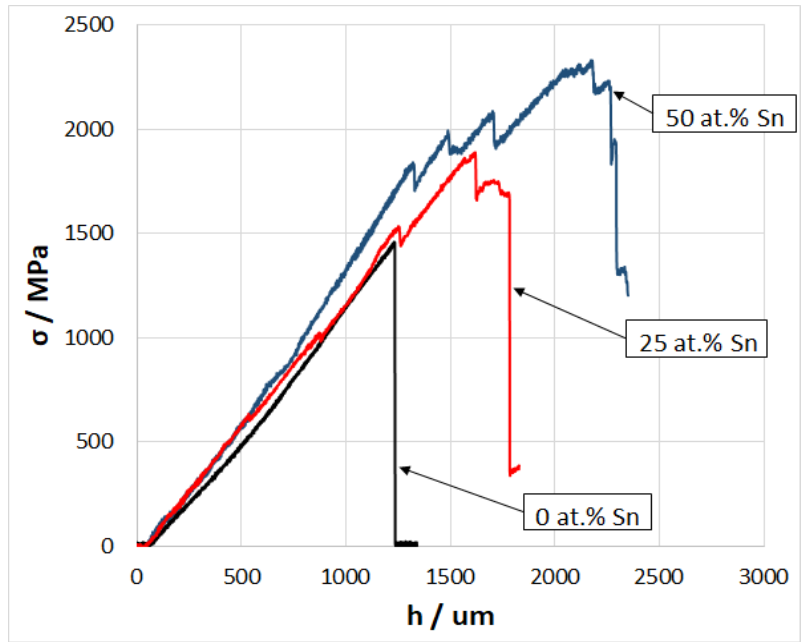
Figure 5. Curves of deformation of a CF/Al-Sn composite with tin content in the matrix of 0 and 50 at.%.